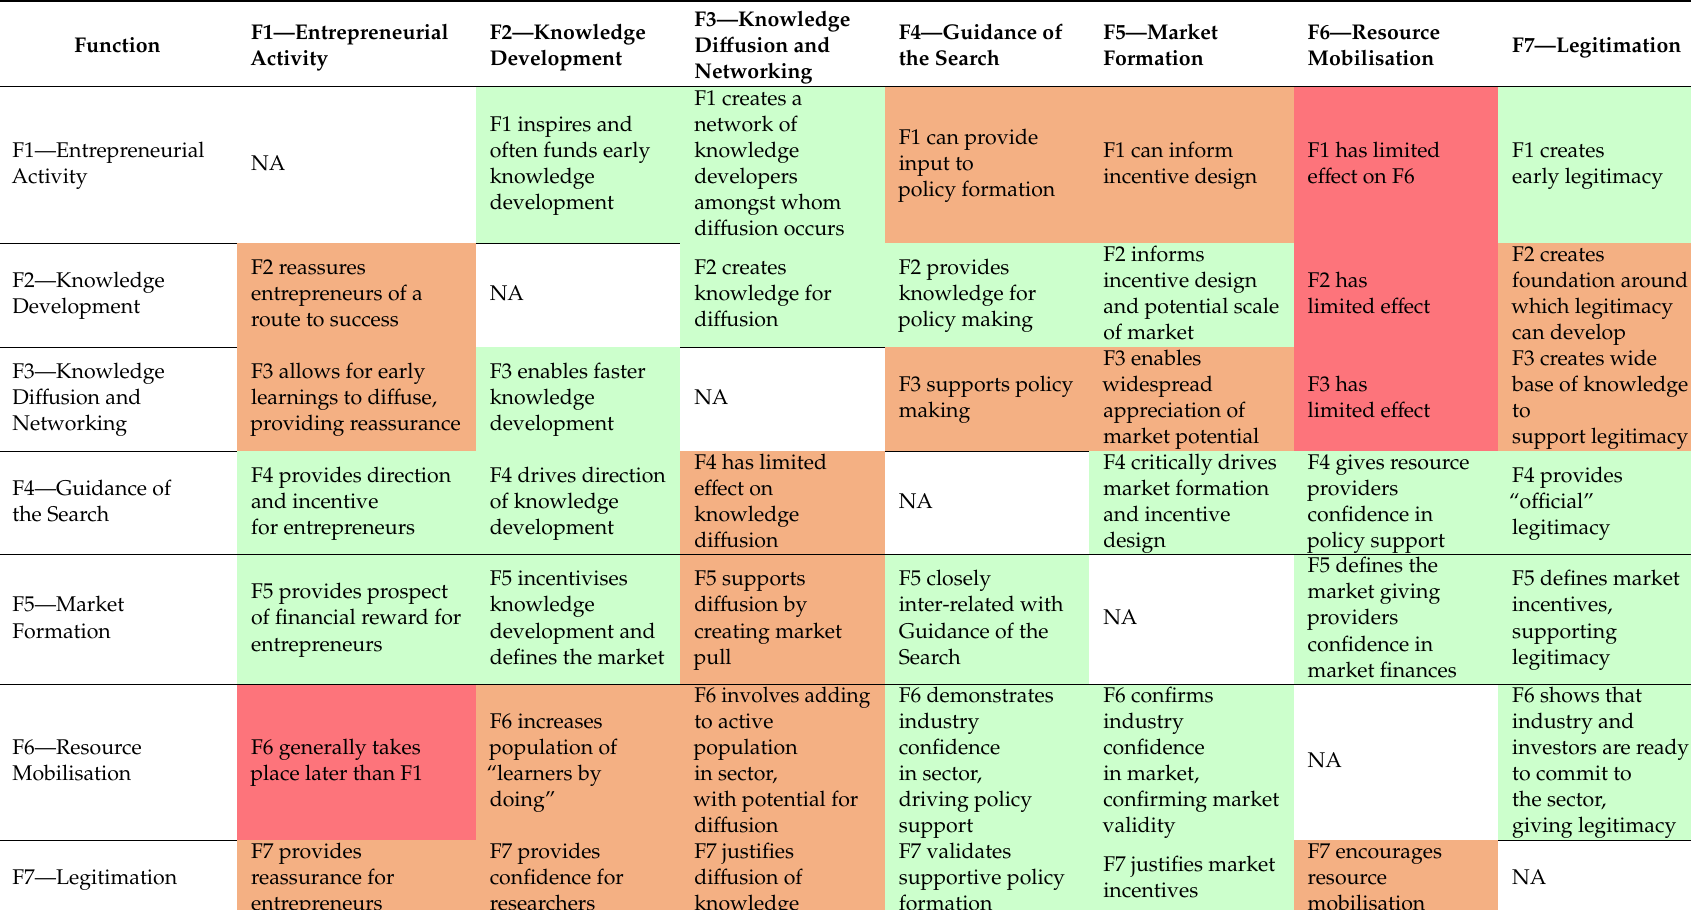
Table 2. Operational relationships between Technological Innovation Systems (TIS) functions (authors’ analysis). Key: green—strong relationship, amber— moderate relationship, red—weak